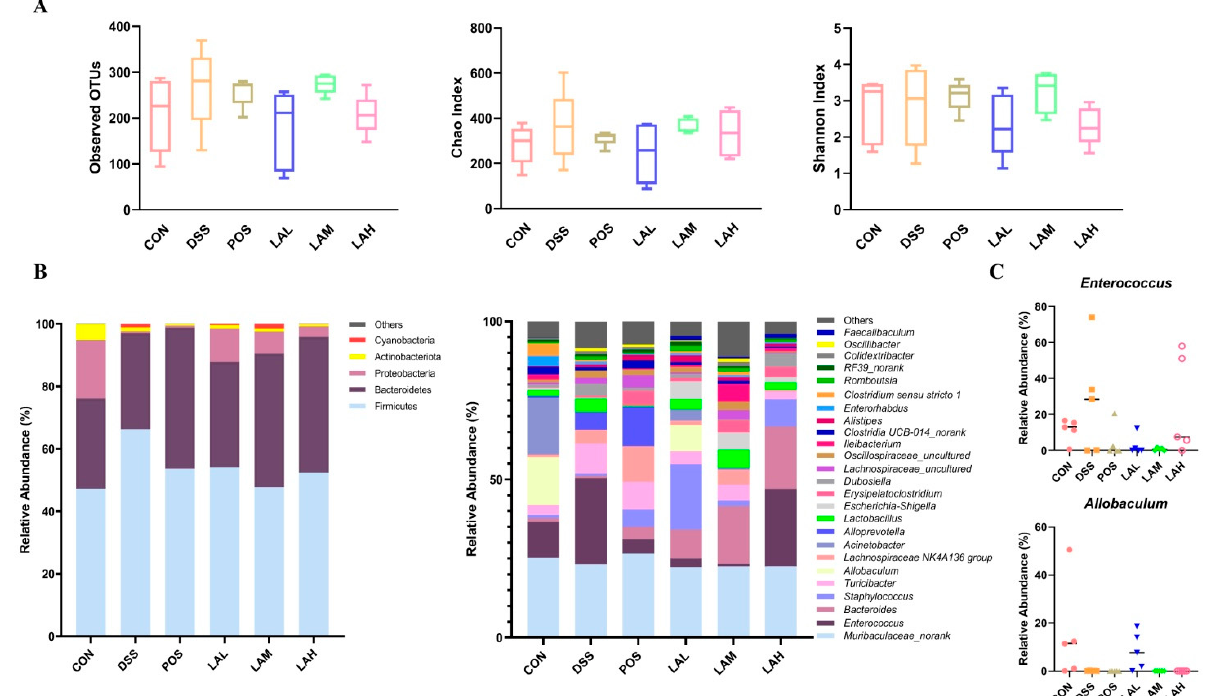
Figure 3. LA regulated the intestinal flora in DSS-subjected mice. ( A ) Observed OTUs, Chao index, and Shannon index. ( B ) Gut bacterial distribution at the phylum and genus levels. ( C ) Relative abundances of Enterococcus and Allobaculum . Data are expressed as mean ± SD ( n = 5).